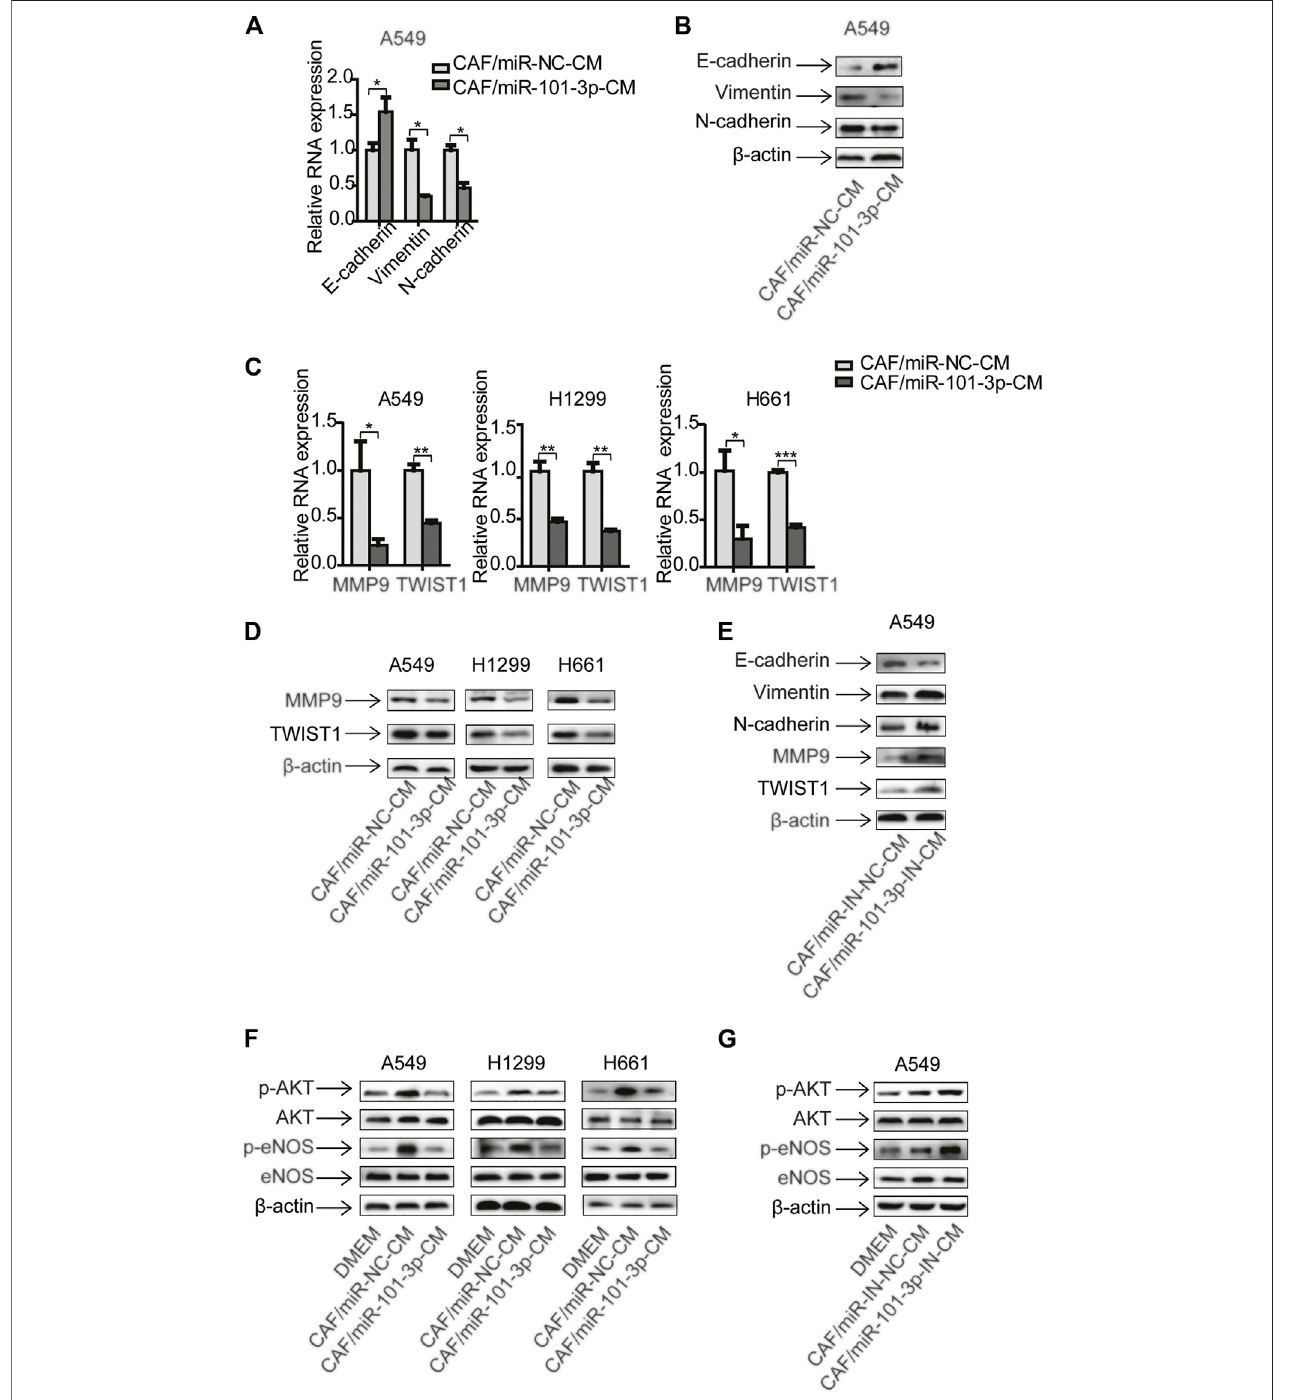
FIGURE 4 | MiR-101-3p in CAFs was responsible for the regulation of EMT and AKT/eNOS signaling pathway in lung cancer cells CAFs were transfected with 100 nM of miR-101-3p mimics. CM was collected and cultured lung cancer cells. The expression of EMT marker genes in lung cancer cells was detected by qPCR (A) and Western blots (B) . The expression of metastasis-related genes in lung cancer cells was detected by qPCR (C) and Western blots (D) . CAFs were transfected with 100 nM of miR-101-3p inhibitor. CM was collected and culture lung cancer cells. The expression of genes in lung cancer cells was detected by Western blots (E) . CAFs were transfected with miR-101-3p mimics or inhibitor. CM wascollected and culture lung cancer cells. The expression of genes in lung cancer cells was detected by Western blots after 48 h (F,G) . Values represent the mean ± SD from 3 independent experiments. * p < 0.05; ** p < 0.01; *** p < 0.001.